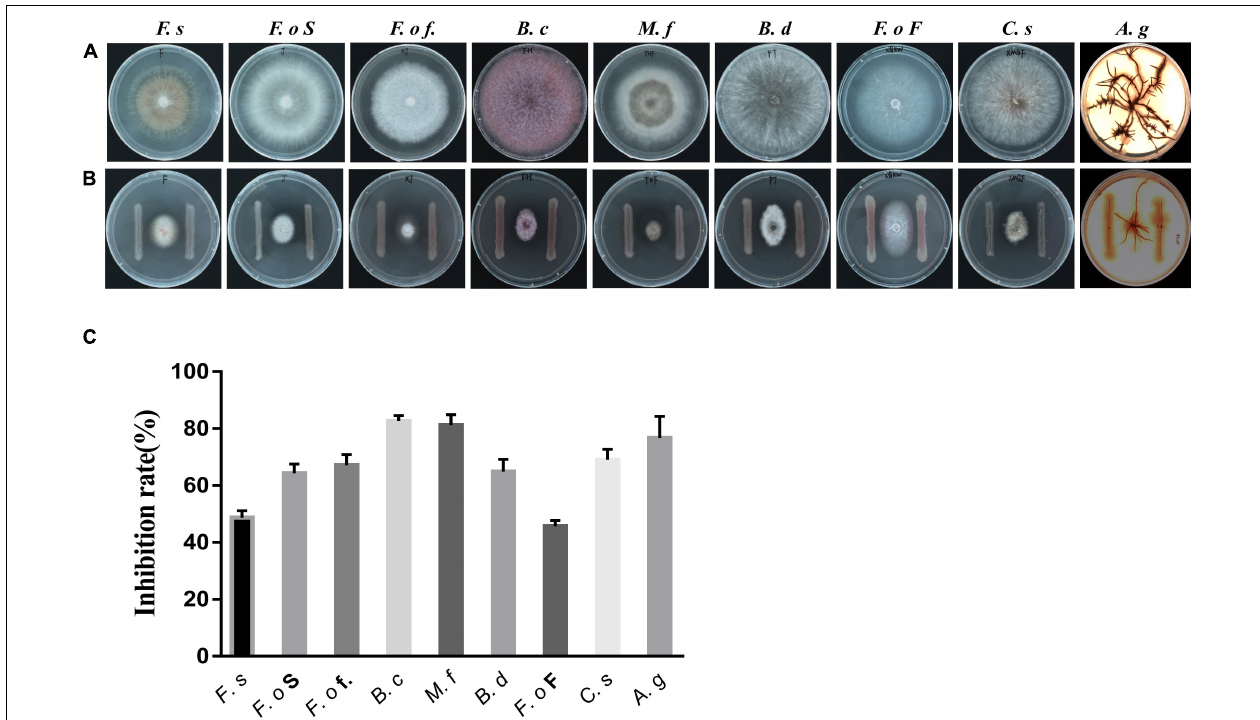
FIGURE 3 | Effect of the isolated bacterial strain on the growth of fungi. (A) : Fungi treated with Pseudomonas strain ZL8; (B) : untreated fungi used as the control group; (C) : strain ZL8 inhibition rate for fungi. F.s : Fusarium solani (pathogen of Salvia miltiorrhiza root rot), F.o S: F. oxysporum (pathogen of S. miltiorrhiza wilt), F.o f.: F. oxysporum f. sp. Cubense (pathogen of panama disease), B.c: Botrytis cinerea (pathogen of tomato gray mold), M.f: Monilinia fructicola (pathogen of peach brown rot), B.d: Botryosphaeria dothidea , F.o F: Fusarium oxysporum f. sp. niveum (pathogen of Fusarium wilt), C.s: Cochliobolus sativus (pathogen of weat common rot), A.g: Armillaria